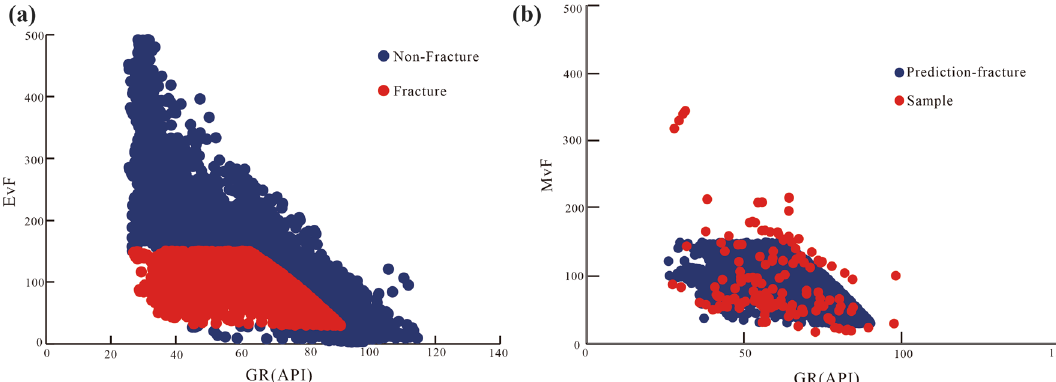
Figure 15. The predicting fracture development data points by MvF are consistent with the data points of fracture